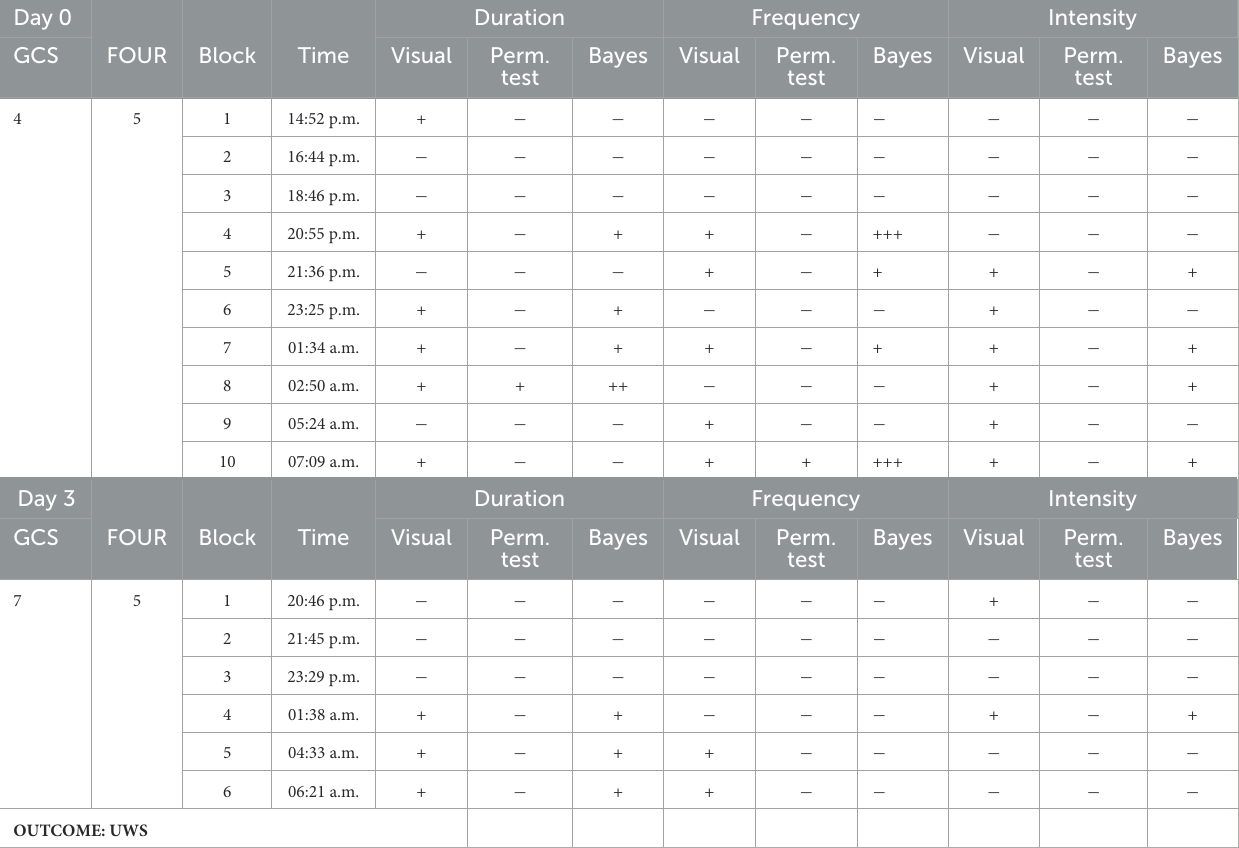
TABLE 6 Summary of the MMN results in Patient 3. Day 0 Duration Frequency Intensity GCS FOUR Block Time Visual Perm.